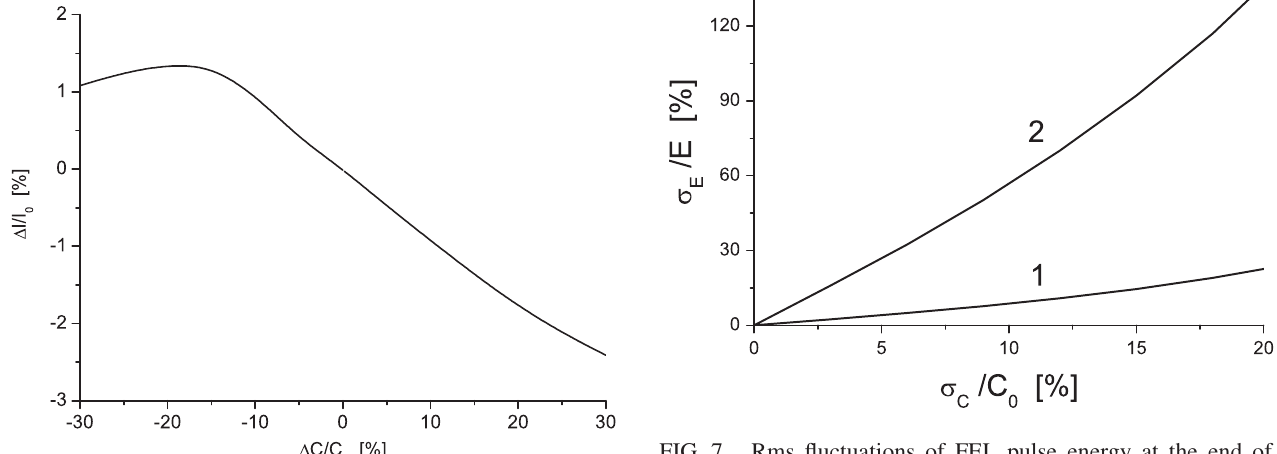
FIG. 7. Rms fluctuations of FEL pulse energy at the end of exponential gain regime ( z ¼ 90 m ) versus rms fluctuations of bunch compression factor for two cases. Curve 1: stabilization scheme is applied; curve 2: standard compression scheme. Intrinsic SASE fluctuations are excluded.